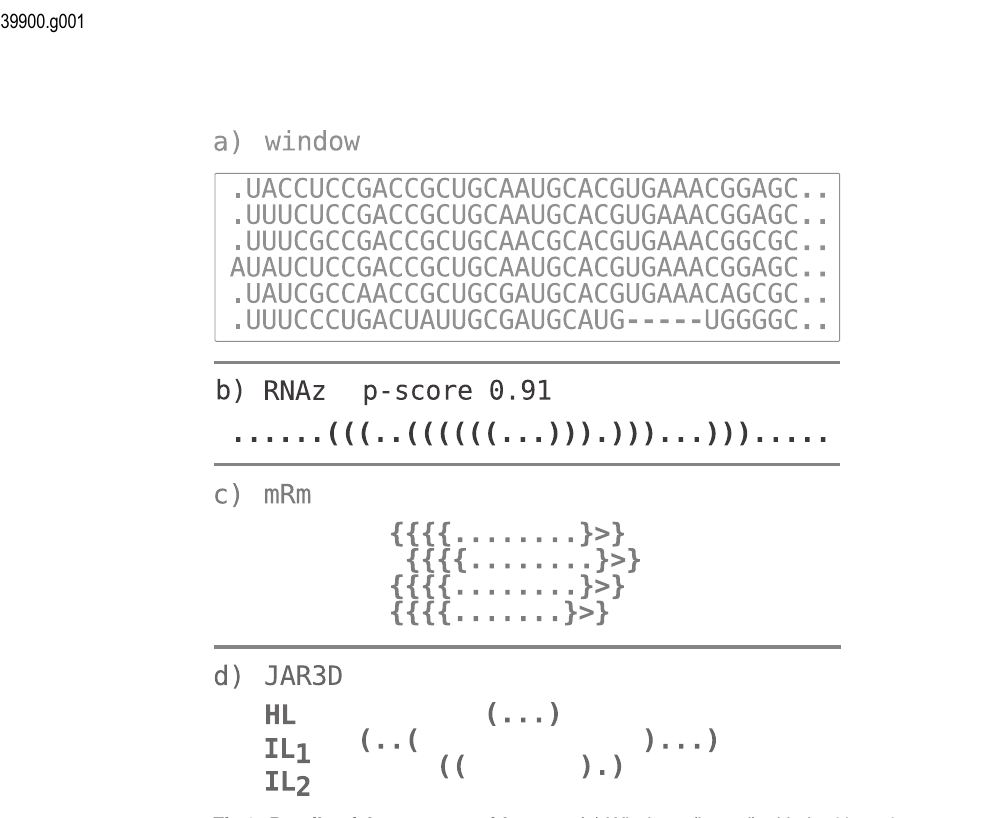
Fig 2. Details of the genome wide scan. (a) Windows (boxed) with the H. sapiens sequence as reference are screened with RNAz for (b) structural motifs. The metaRNAmodules models are applied on each sequence of the window (c) whereas the JAR3D models are applied on loop regions of the RNAz consensus structure (d). In both cases, predictions of different models can overlap. The same procedure is used to scan the shuffled